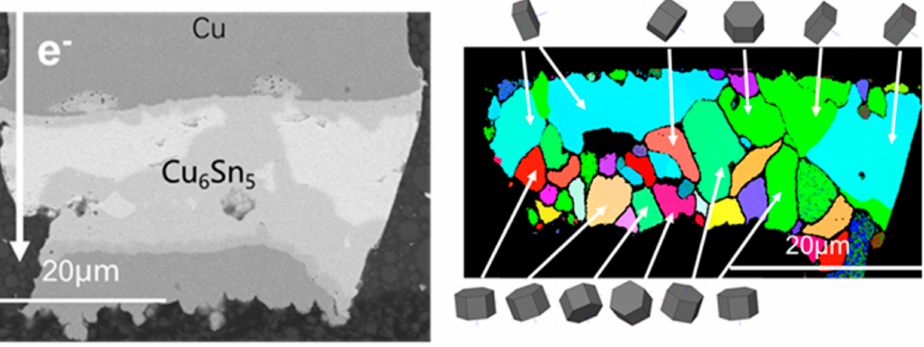
Figure 7. Microstructure after current stressing at 1.5 × 10 4 A/cm 2 at 125 ◦ C for 600 h. 3.4. Microhardness and Elestic Modulus of IMCs in Copper Pillar Joint after Electromigration Test Microstructure morphology, nanoindentation on Cu 6 Sn 5 and Cu 3 Sn and grain struc- ture of solder joint tested by electromigration for 800 h under 1 × 10 4 A/cm 2 at 150 ◦